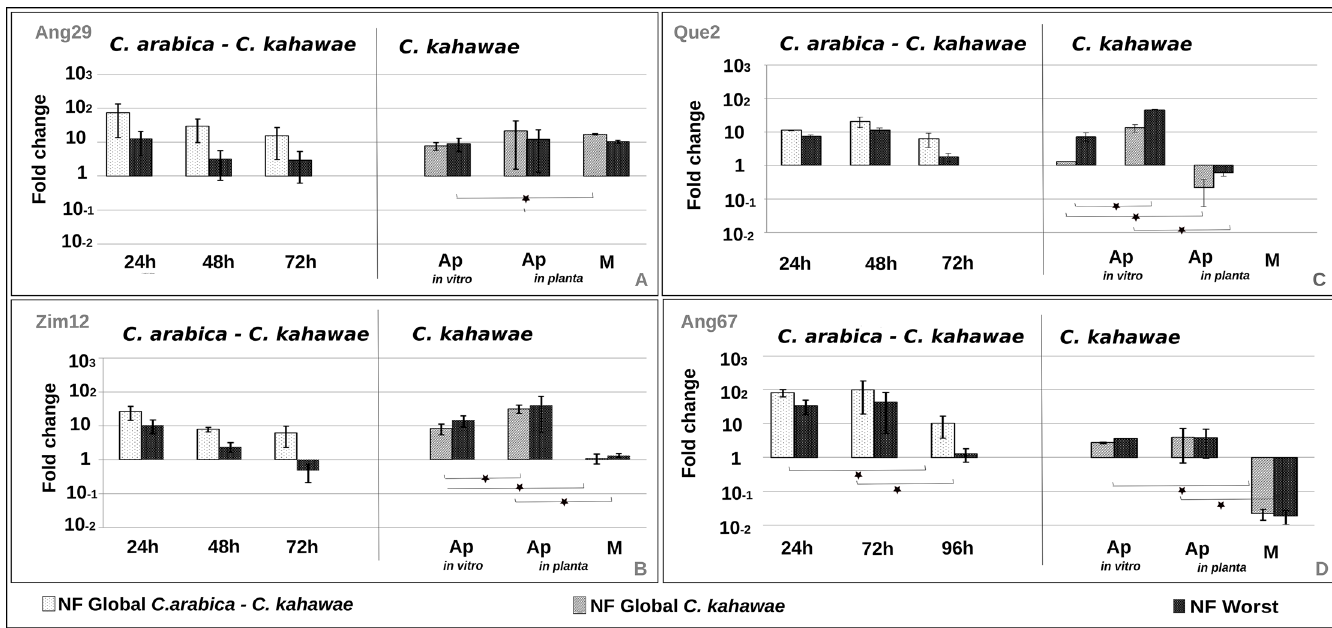
Fig 3. Relative quantification of thr1 expression using the Best and the Worst normalization factors (NF). Expression profiles are presented per isolate (Ang29 (A), Zim 12 (B), Que2 (C) and Ang67 (D)), during the early stages of infection process and growth (Ap: Appressoria; M: Mycelium). The C . arabica – C . kahawae samples were normalized with NF Global C . arabica — C . kahawae interaction ( PP1; Act; ck34620) and NF Worst ( ck20430; ck48742; ck36020) , while the C . kahawae samples were normalized with NF Global C . Kahawae ( PP1; Act; ck20430 ) and NF Worst ( ck34620; ck36020 ).